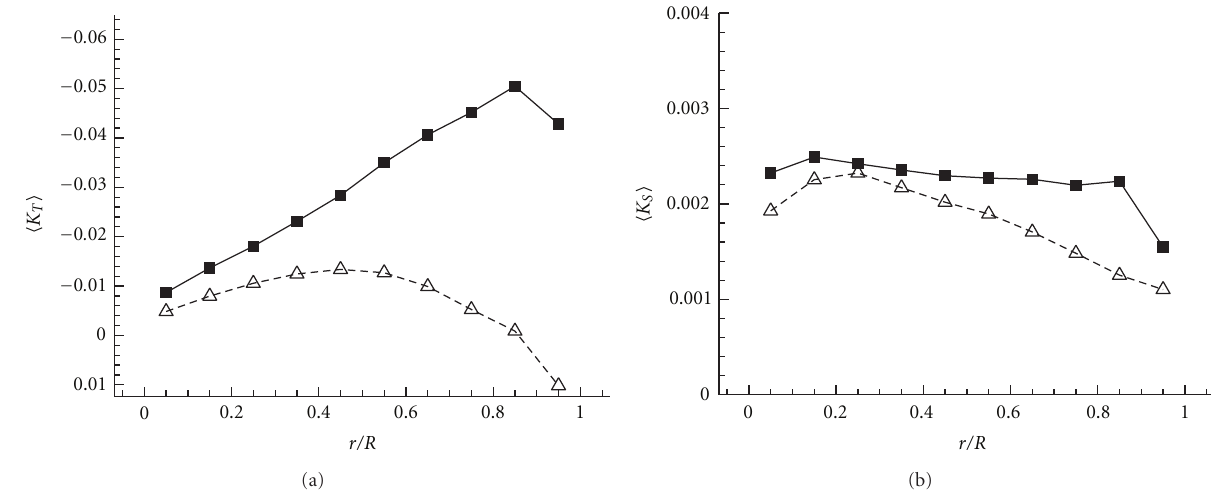
Figure 6: Blade loadings on radially divided sections for open propulsor at J = − 0 . 7: (a) (cid:2) K T (cid:3) , (b) (cid:2) K S (cid:3) ( (cid:2) suction side, (cid:4) pressure side).